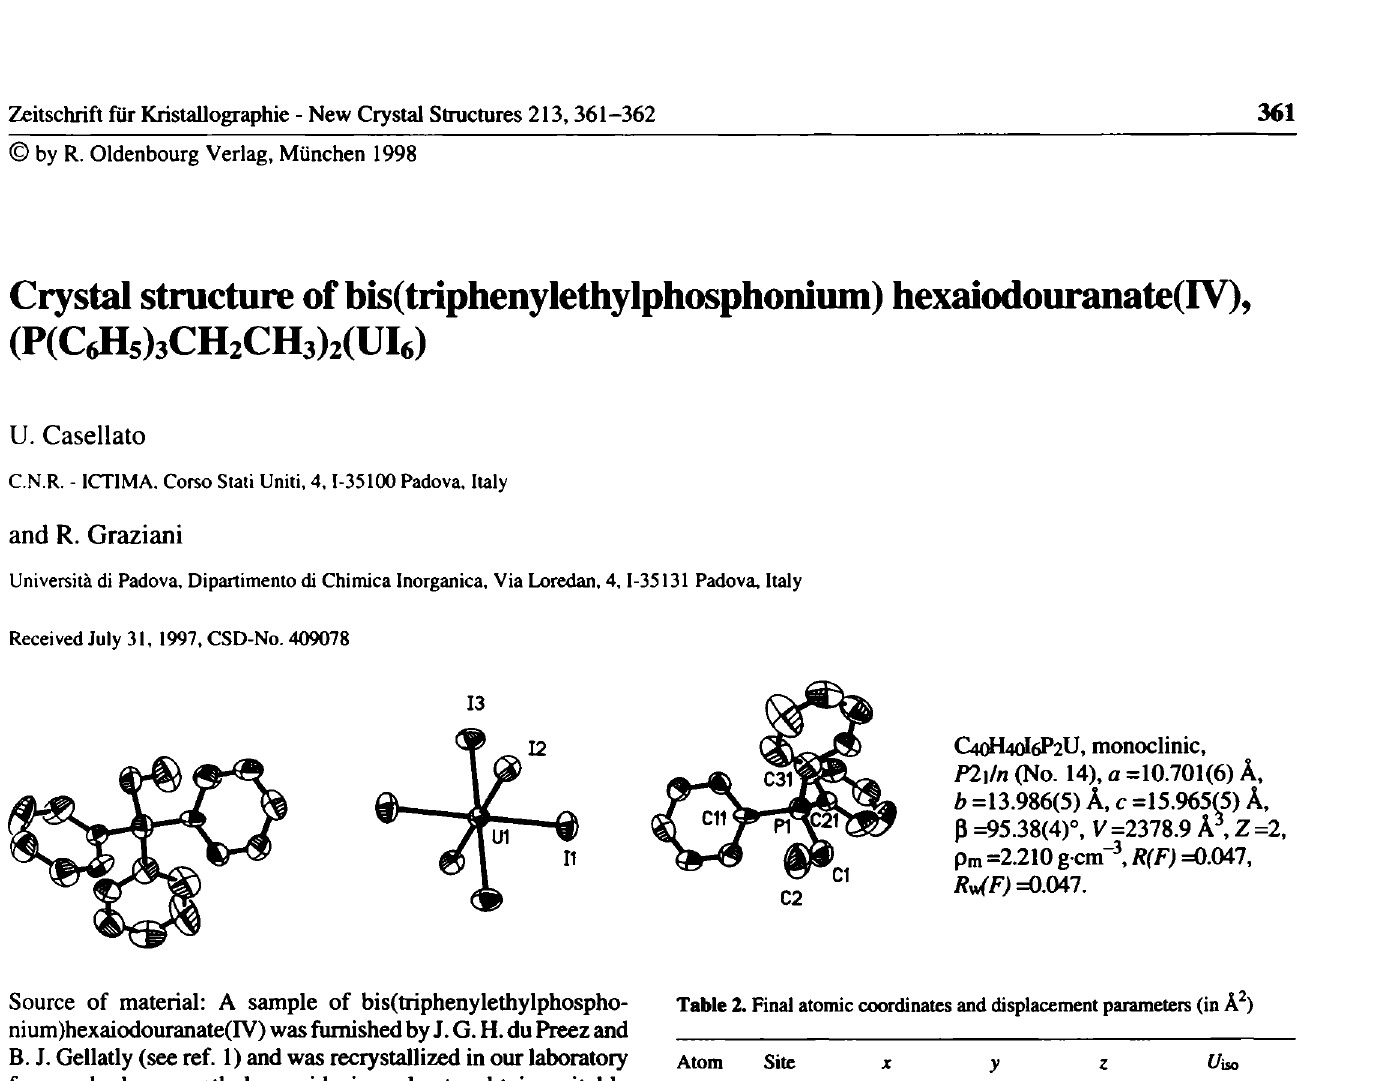
Table 1. Parameters used for the X-ray data collection